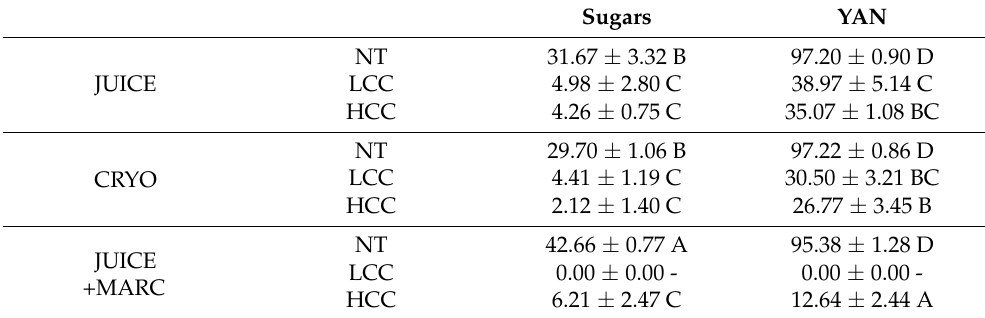
Table 3. Percentages of consumption of sugars and YAN (yeast assimilable nitrogen) after 48 h.